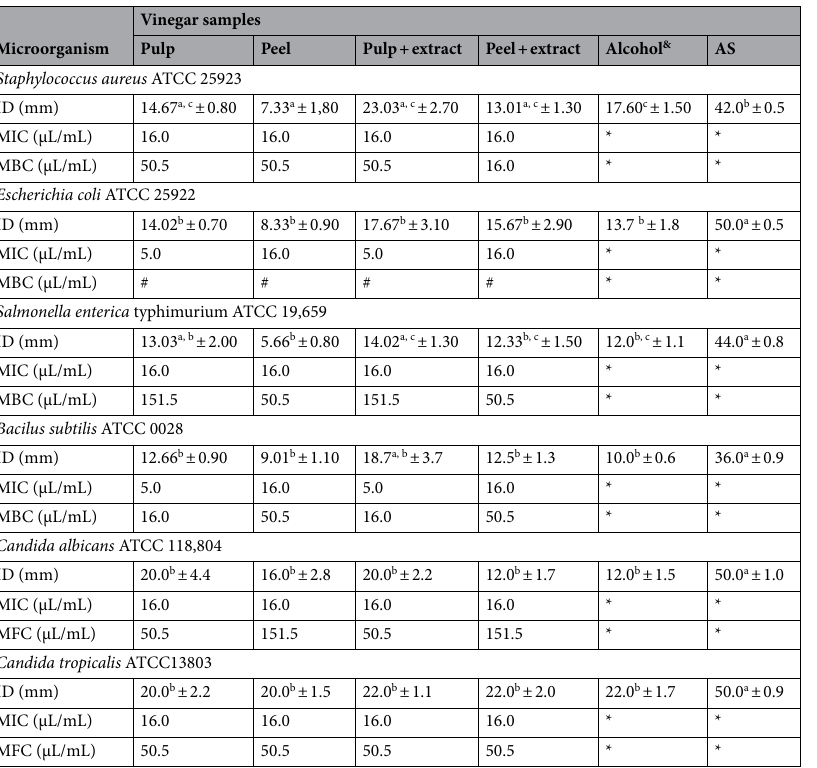
Table 5. Antimicrobial and antifungal potential of pineapple vinegar samples. AS, standard antimicrobial, tetracycline for bacteria and fluconazole for fungi); ID, diameter of the inhibition zones (inhibition halo); MIC, minimum inhibitory concentration; MBC, minimum bactericidal concentration; MFC, minimum fungicide concentration. *, not evaluated; # , no inhibition; & , commercial alcohol